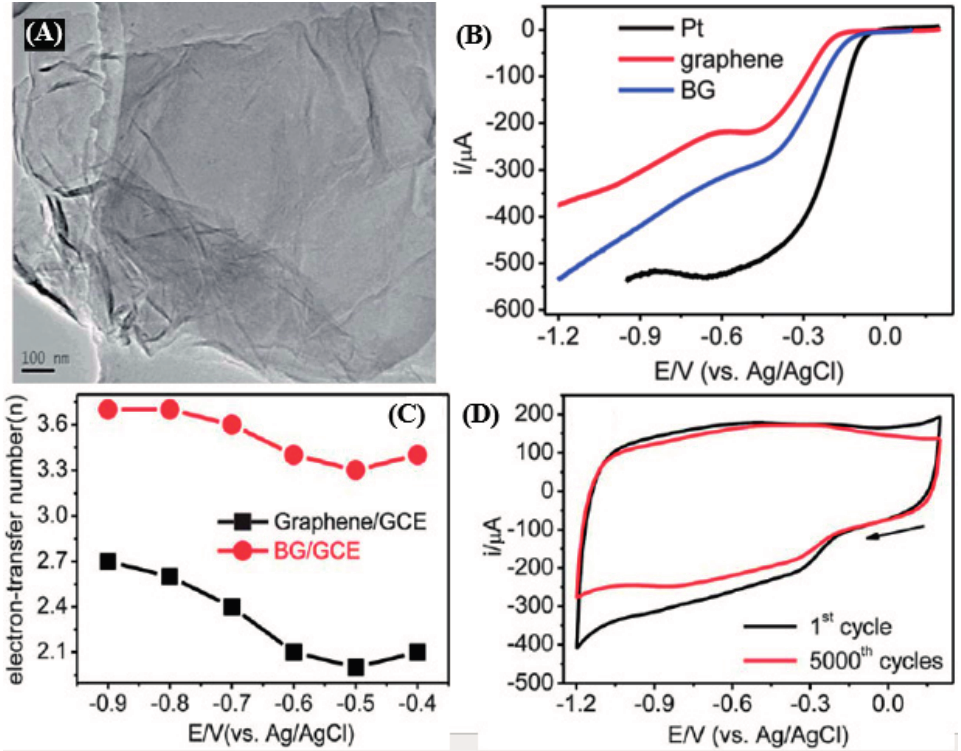
Figure 9. ( A ) TEM image of boron-doped graphene (BG). ( B ) Liner sweep voltammetric curves (LSVs) of ORR for graphene/GCE (red), BG/GCE (blue) and bulk Pt disk electrode (black) in an O 2 -saturated 0.1 M KOH aqueous solution (scan rate: 10 mV·s-1). The rotation rate of RDE was 1200 rpm. ( C ) The dependence of n on potential for the BG/GCE and pure graphene/GCE. ( D ) CVs of BG/GCE for ORR in O 2 -saturated 0.1 M KOH aqueous solution. The first scan (black) and the 5000th scan (red). Scan rate: 100 mV·s − 1 . Reproduced from [131] with permission from the Royal Society of Chemistry,